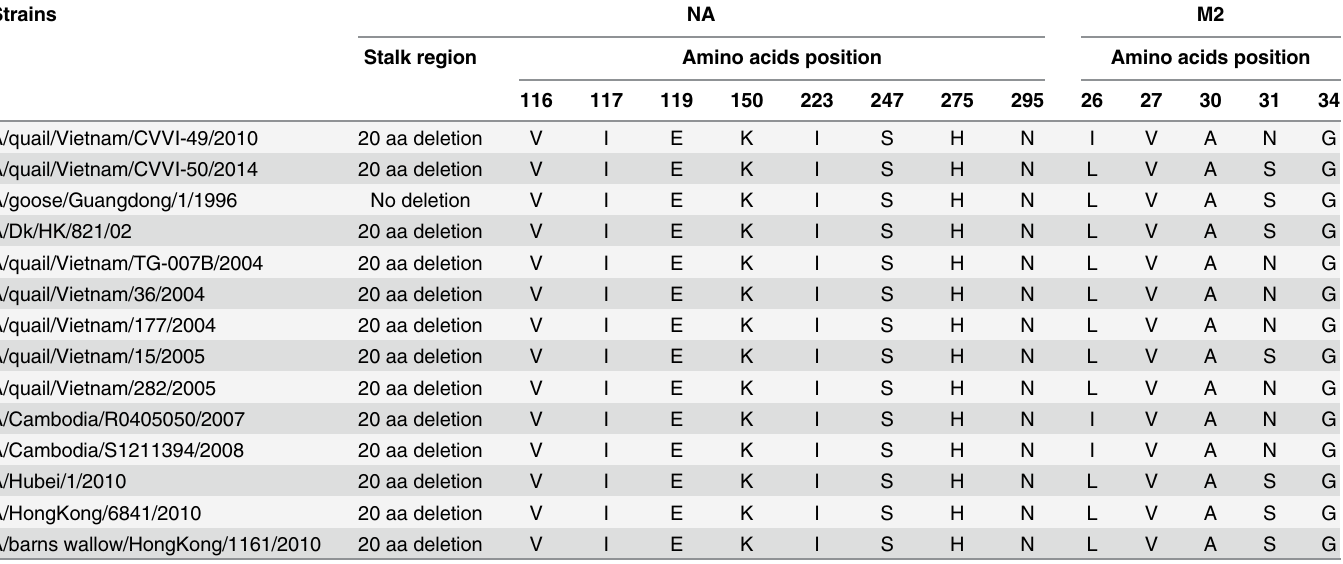
Table 2. Antiviral resistance markers in the NA and M2 genes of the CVVI-49/2010 and CVVI-50/2014 strains relative to some genetically related strains.